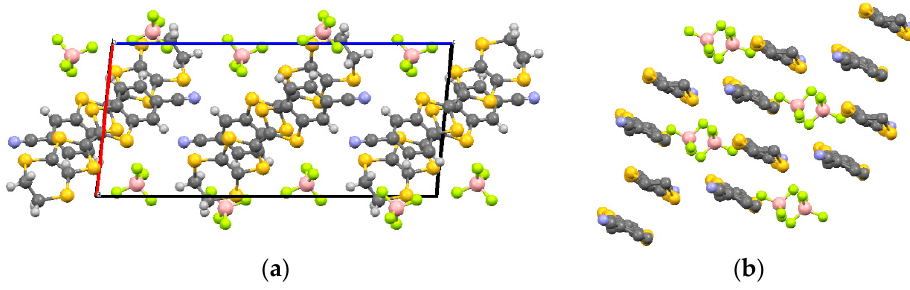
Figure 1. Crystal structure of (CNB-EDT-TTF) BF 4 ; ( a ) viewed along the axis; ( b ) partial view along the molecular long axis of a layer of head to tail donor dimers.